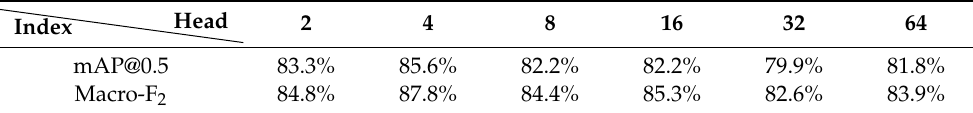
Table 6. Performance of TR–YOLOv5s with different numbers of heads in transformer module.